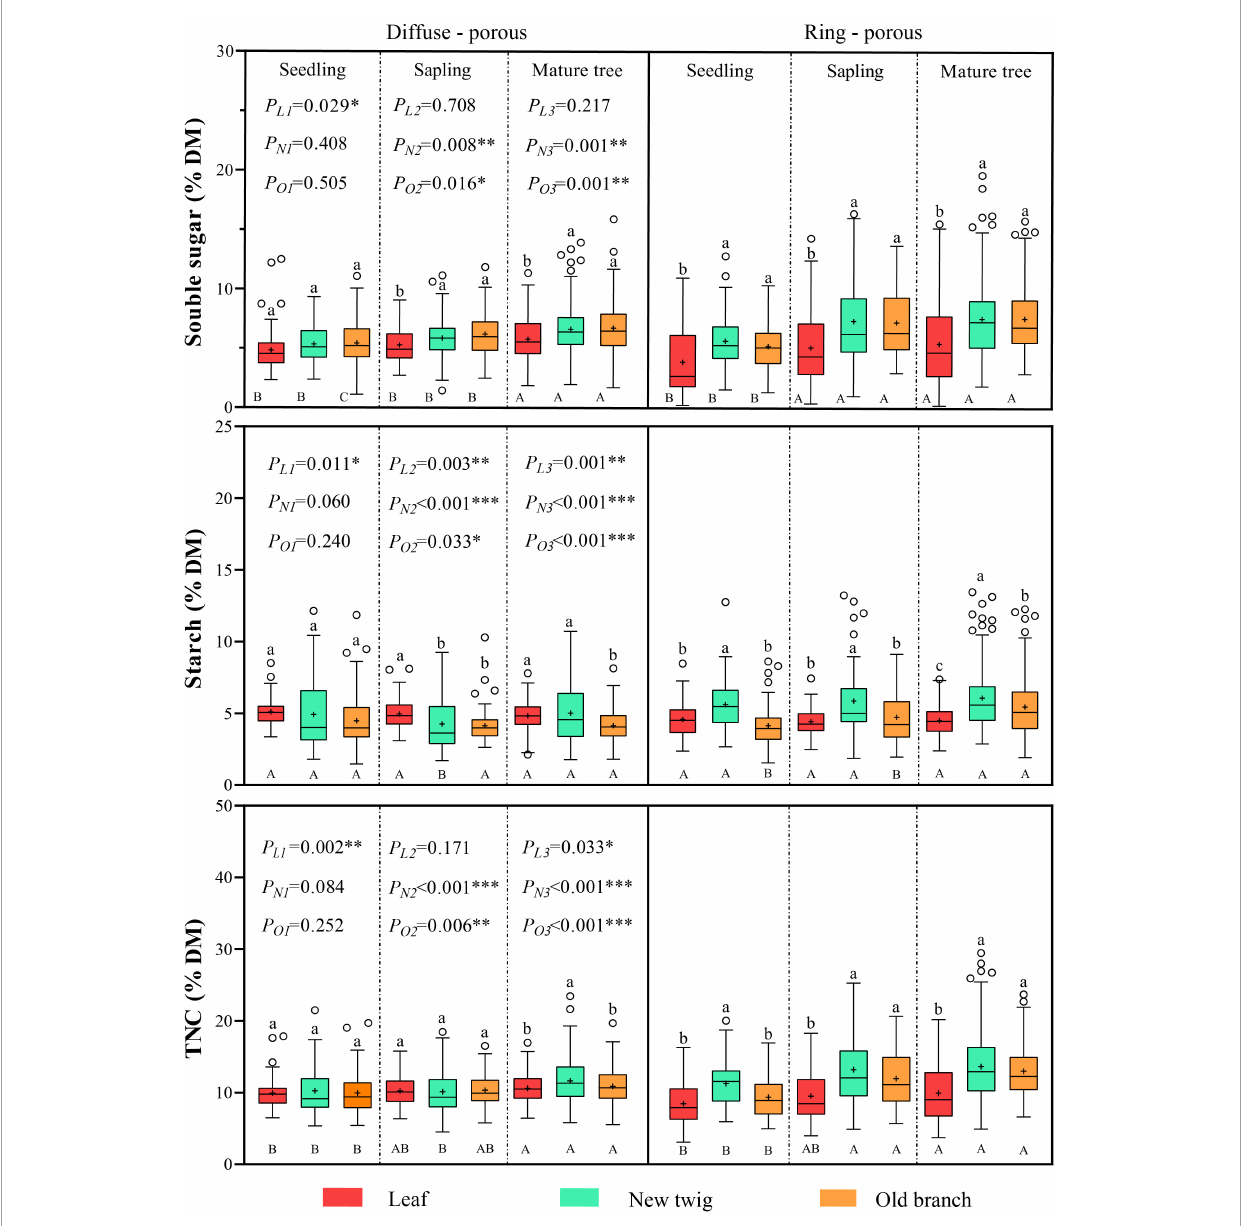
FIGURE2 Non-structural carbohydrates (NSC) content in different organs of diffuse-porous and ring-porous species at each life history stage. Capital and lowercase letters indicate the differences between life history stages and organs under same wood types, respectively; P -values represent the comparison of leaves, new twigs and old branches in two species of wood types at the same life history stage, in which L, N, and O represent leaves, new twigs and old branches respectively; 1, 2, and 3 represent seedlings, sapling, and mature trees, respectively. Dots indicate outliers and “+” indicates mean values. ∗ p < 0.05, ∗∗ p < 0.01, ∗∗∗ p <